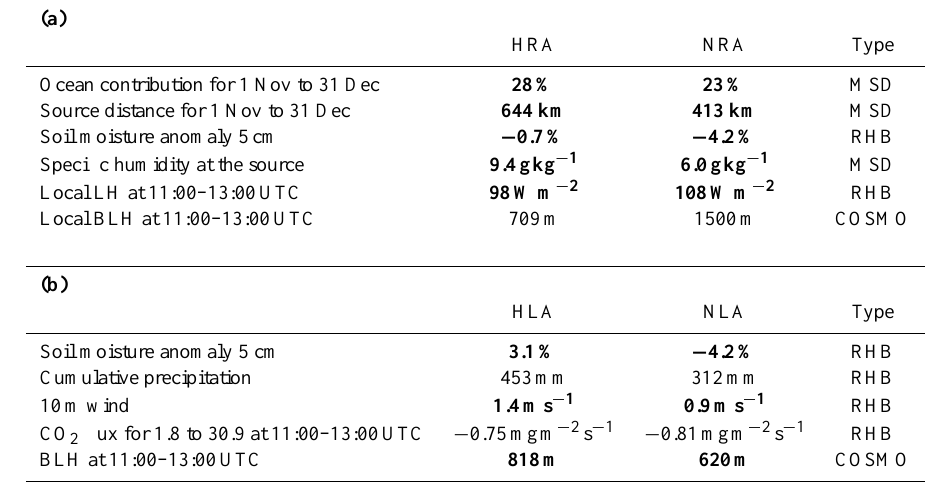
Table 4. Median values of the conditions during HRA and NRA events (a) and during HLA and NLA events (b) . The ocean moisture source contribution, the source distance, the explained fraction and the specific humidity at the source are properties of the moisture source diagnostics (MSD in the Type column, see Sect. 3.2). The boundary layer height (BLH) was interpolated to the Rietholzbach site from the COSMO model. LH denotes the latent heat flux measured locally at Rietholzbach (indicated by RHB in the Type column). Negative CO 2 fluxes are downward. Numbers in bold indicate statistically significant differences between the median of the HRA and NRA distributions in (a) and between HLA and NLA distributions in (b) according to a Wilcoxon rank sum test (Gibbons and Chakraborti, 2011). For the ocean contribution and the source distance the difference is shown only for the cold season as for the whole time period the difference is not